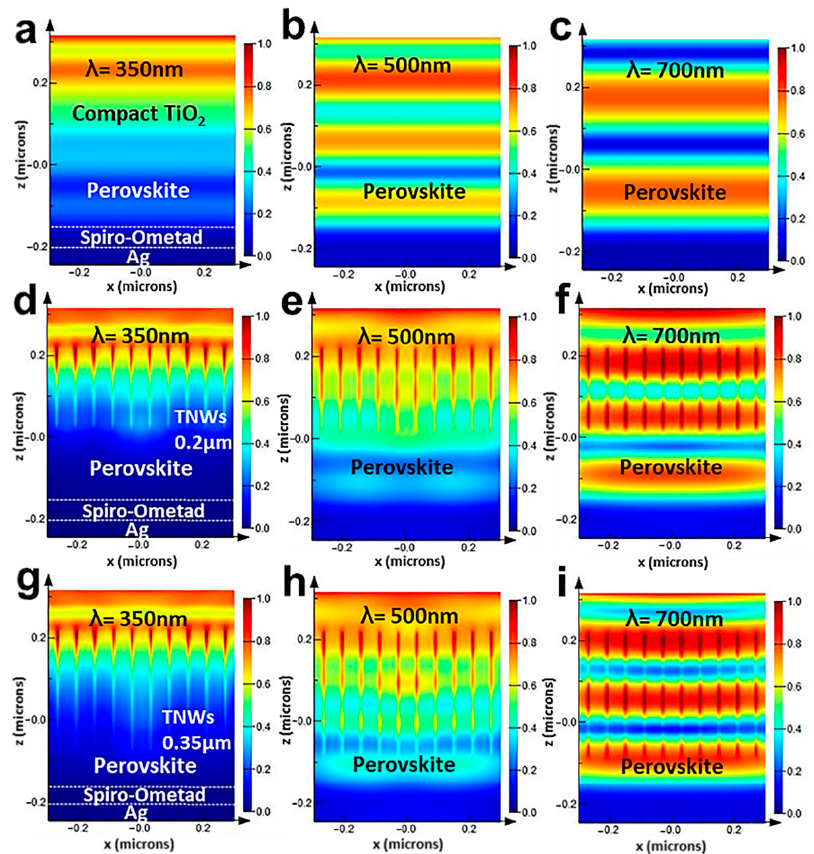
Figure 4. The 3D mesh of perovskite devices integrated for FDTD over the wavelengths of 350 nm, 500 nm, and 700 nm. ( a – c ) The planar device with TiO 2 presented to compare the intensity of the electric field. ( d – i ) The electric field distributions within the devices are compared based on the influence of changing length of the TNWs from 0.2 to 0.35 µm.